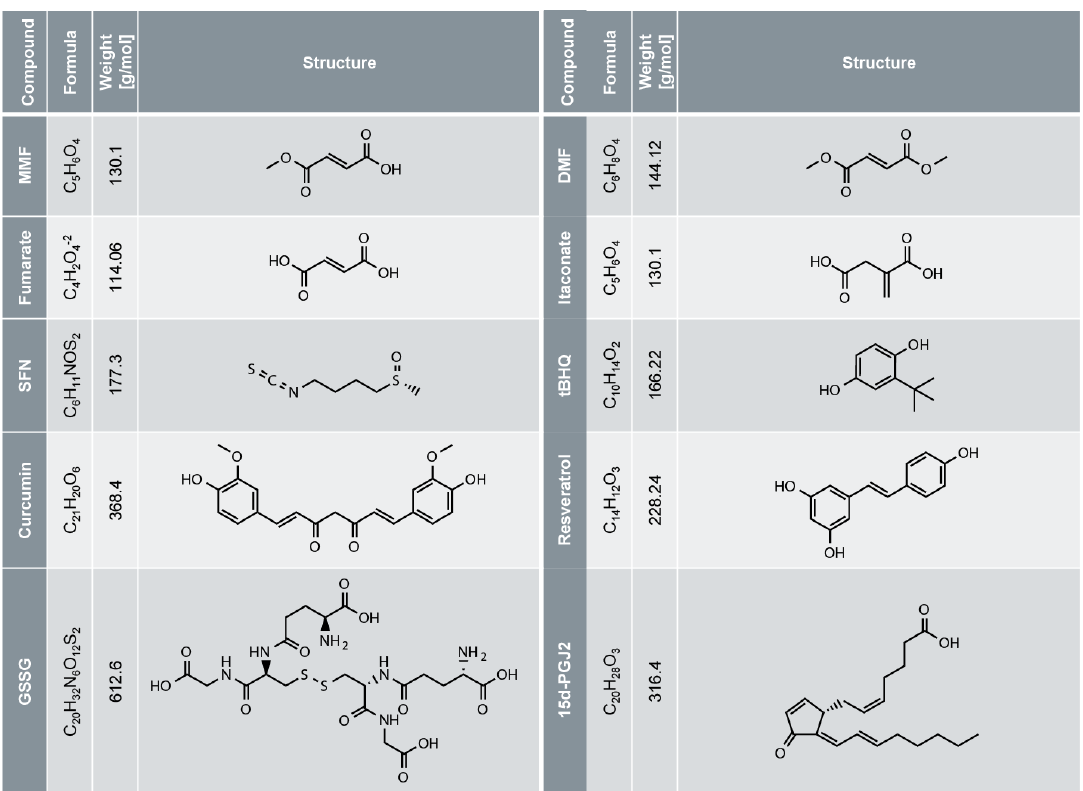
Figure 3. Structure of different NRF2-activating electrophiles. Name, formula, molar weight and structure of different electrophiles activating NRF2.